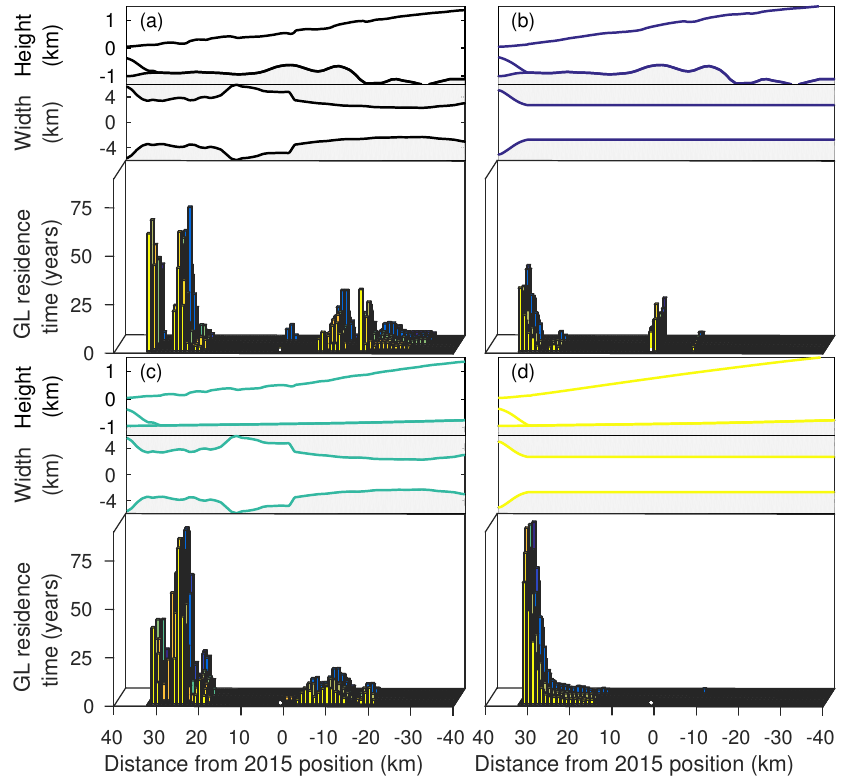
Figure 6. Residence time of the grounding line (GL) for the different geometries presented in Sect. 3.4: (a) the original geometry, (b) straight- ened width, (c) straightened bed, and (d) straightened width and bed. The bars represent the time that the grounding line rests within 1km, and the colors correspond to the model runs in Table 2. Only residence times of more than 2 years are